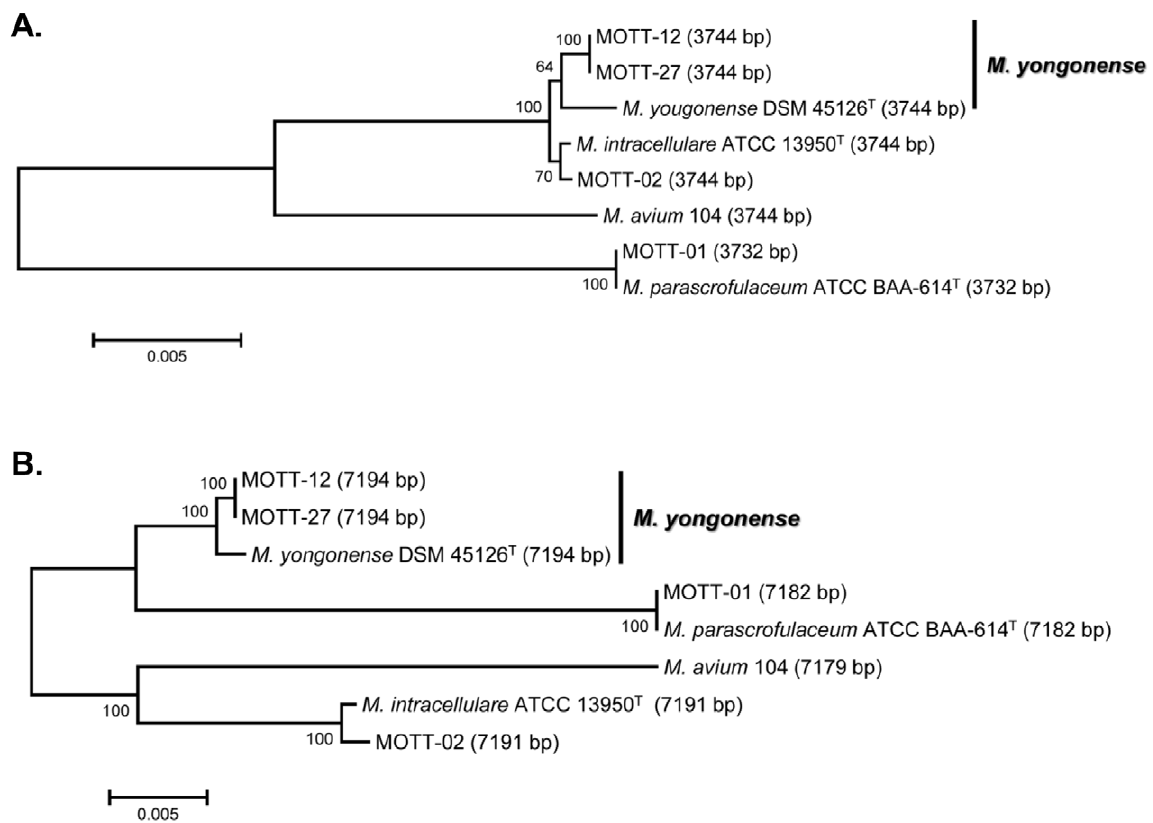
The effect of adding the rpoB sequence to the concatenated sequences of the five MLSA genes (7182–7194 bp) was also studied. The topology of the obtained tree (Figure 2B) was